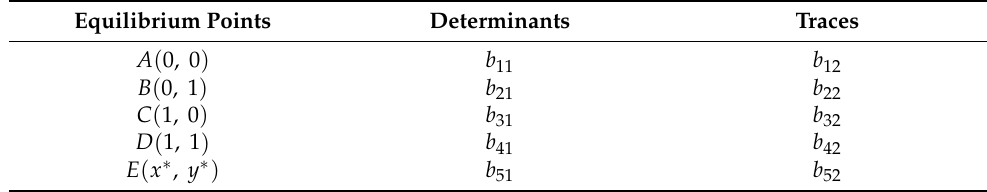
Table 3. Results of determinants and traces of Jacobian matrix at each equilibrium point. Equilibrium